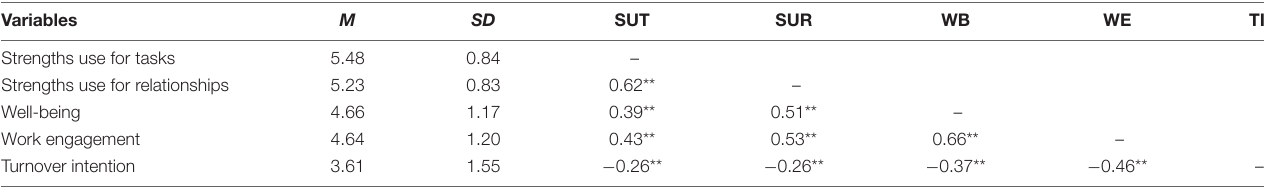
TABLE 4 | Means, standard deviations, and correlations among study variables. Variables M SD WE TI